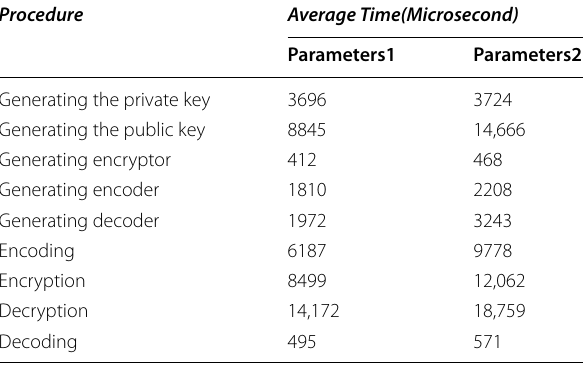
Table 3 Computing time of every stage on client